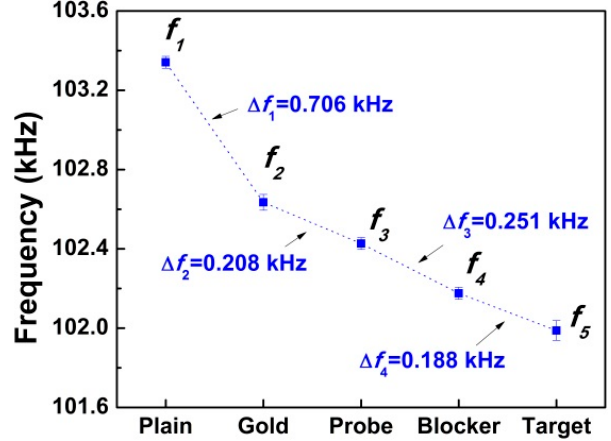
Figure 8. Frequency spectrum of the biosensor after different steps.